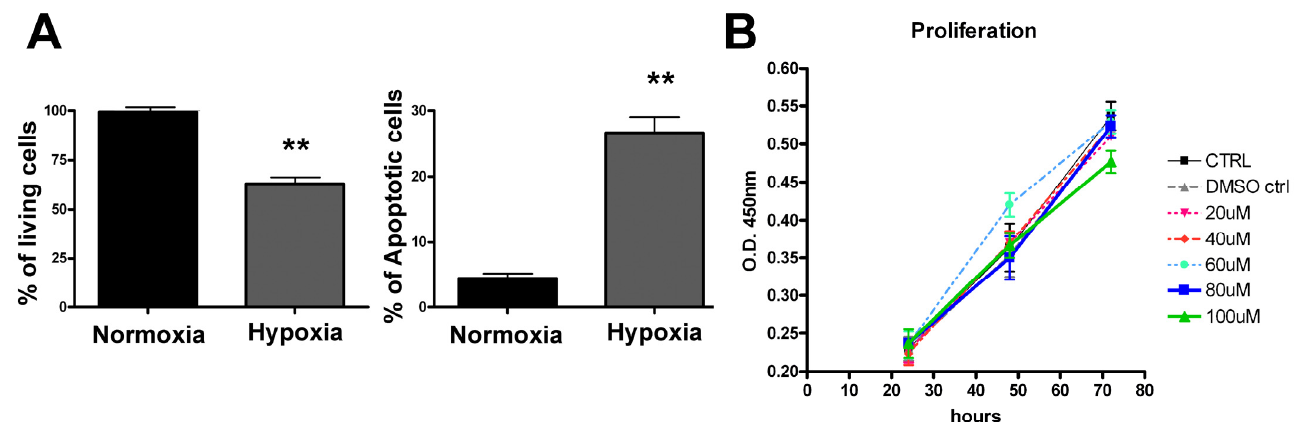
Figure 1. Hypoxic treatment induces cell death in PC12 cells. PC12 cells were seeded in two 6 well plates and subjected to hypoxia in an airtight chamber supplied with hypoxic gases for 6 h at 37 °C. The other plate was maintained at standard culture conditions (normoxia). Post-hypoxic treatment: both the culture plates were maintained in fresh medium at standard culture conditions and harvested after for 24 h. ( A ) Apoptotic cells were detected using a fluorescein conjugated with Annexin V kit. The bar graph represents quantification in percentage values of live cells and the apoptotic cell death comparison between normoxic vs. hypoxia-treated cells. ( B ) The cytotoxic effect of RSV was analyzed by CCK-8 assay. Data expressed as mean ± SD (** p < 0.01) of triplicate experiments.